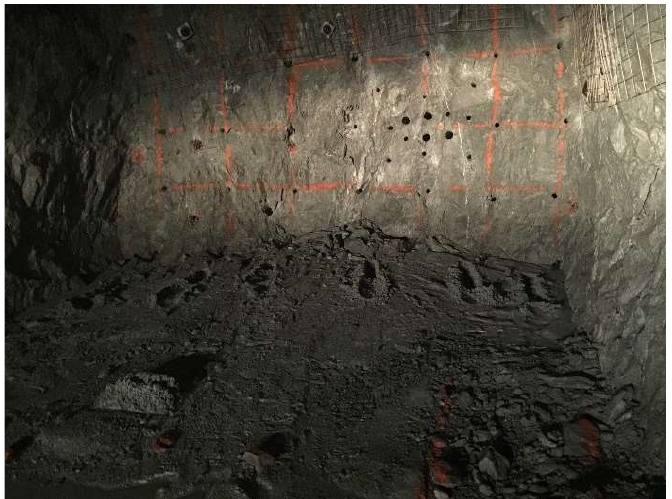
Figure 3. Drive floor showing the high level of fine material accumulated after blasthole drilling. Some of this material will remain even after removal of the blast round. Drive width 5